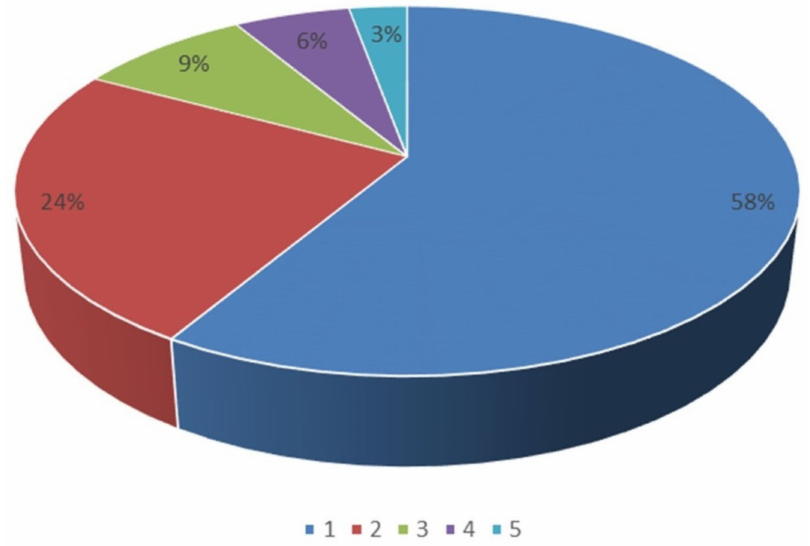
Figure 8. The genesis of the formed sinkholes: 1—galleries; 2—extracted parts of deposit; 3—shafts; 4—open pit working; 5—faults.